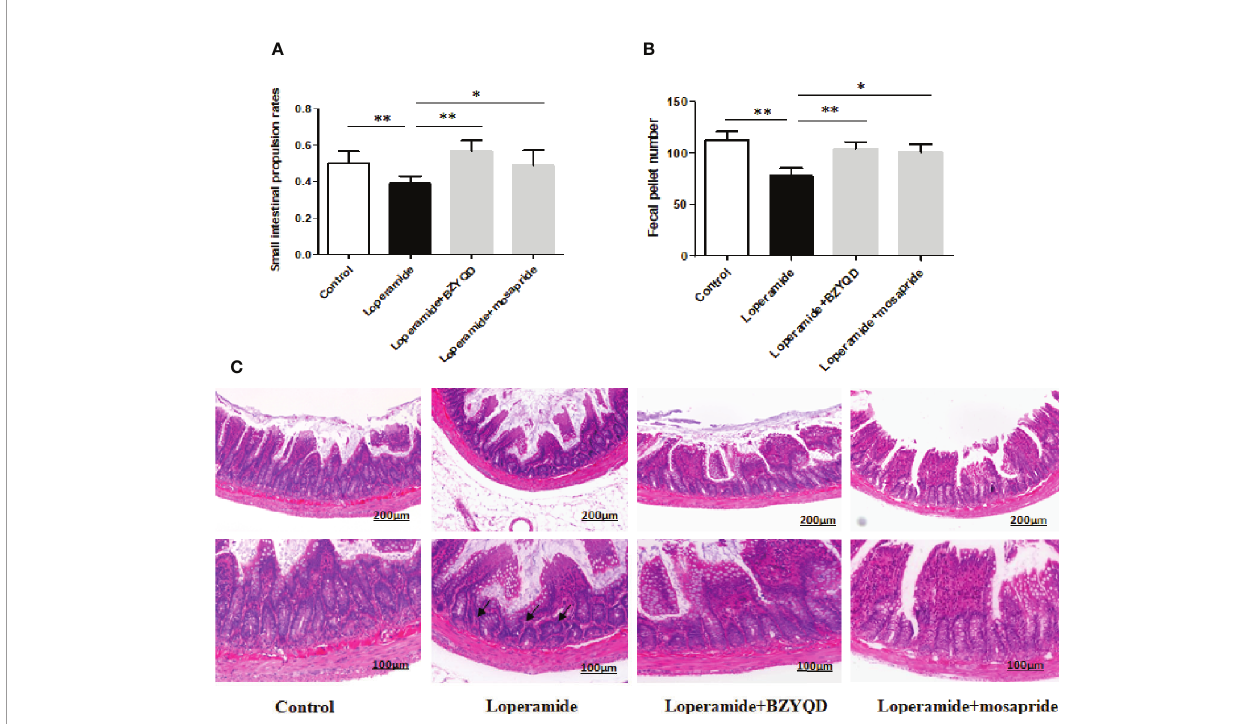
FIGURE 3 | Effect of BZYQD intervention on loperamide-induced constipation in rats. (A) Small intestinal transit rates of rats of Control group, Loperamide, Loperamide + BZYQD, and Loperamide + Mosapride groups. (B) Number of stools of rats of Control group, Loperamide, Loperamide + BZYQD, and Loperamide + Mosapride groups. (C) Hematoxylin and eosin (H&E)-staining for light microscopy analysis of colon sections in rats of the control group, Loperamide group, Loperamide + BZYQD group, Loperamide + Mosapride groups morphology. Arrow marks pointed to that epithelial surface of the rat colon was damaged, mucosa was thinner, gland was reduced, goblet cells were reduced, and the in fl ammatory cells in fi ltrated in the lamina propria in the loperamide group. n = 8; Original magni fi cation ×100 or ×200; data are represented as mean ± SD. # P < 0.05 versus control group; * P < 0.05versus loperamide group, ** P < 0.01 versus Loperamide